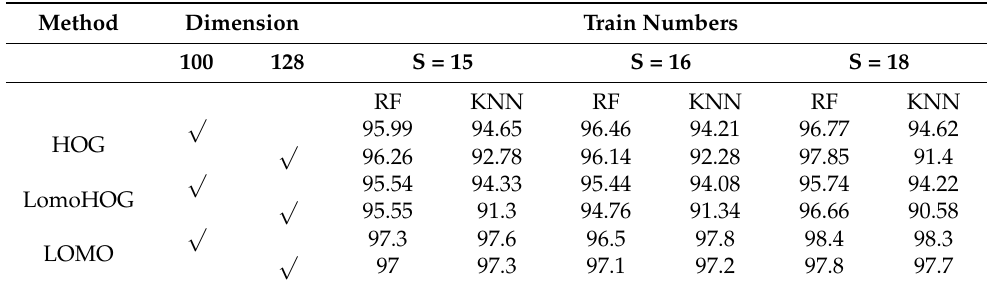
Table 8. Mixed multilanguage signature recognition results were based on different features.